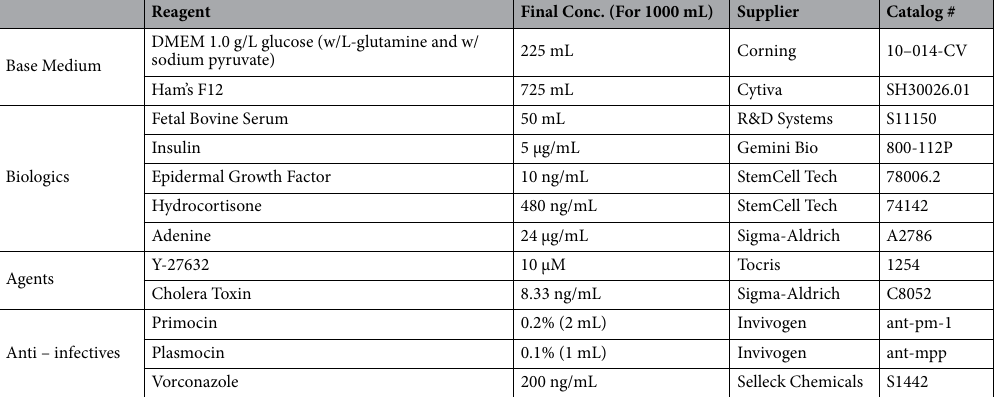
Table 1. FYRM medium composition. This formulation produces medium containing 150 mg/dL glucose as measured using a colorimetric assay. For details related to medium preparation, see